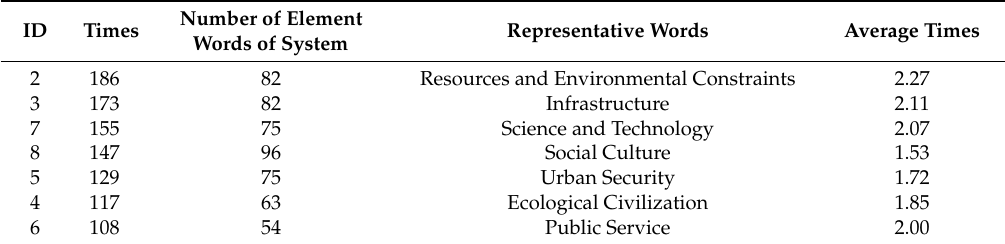
Table 3. Primary indicators of urban comprehensive carrying